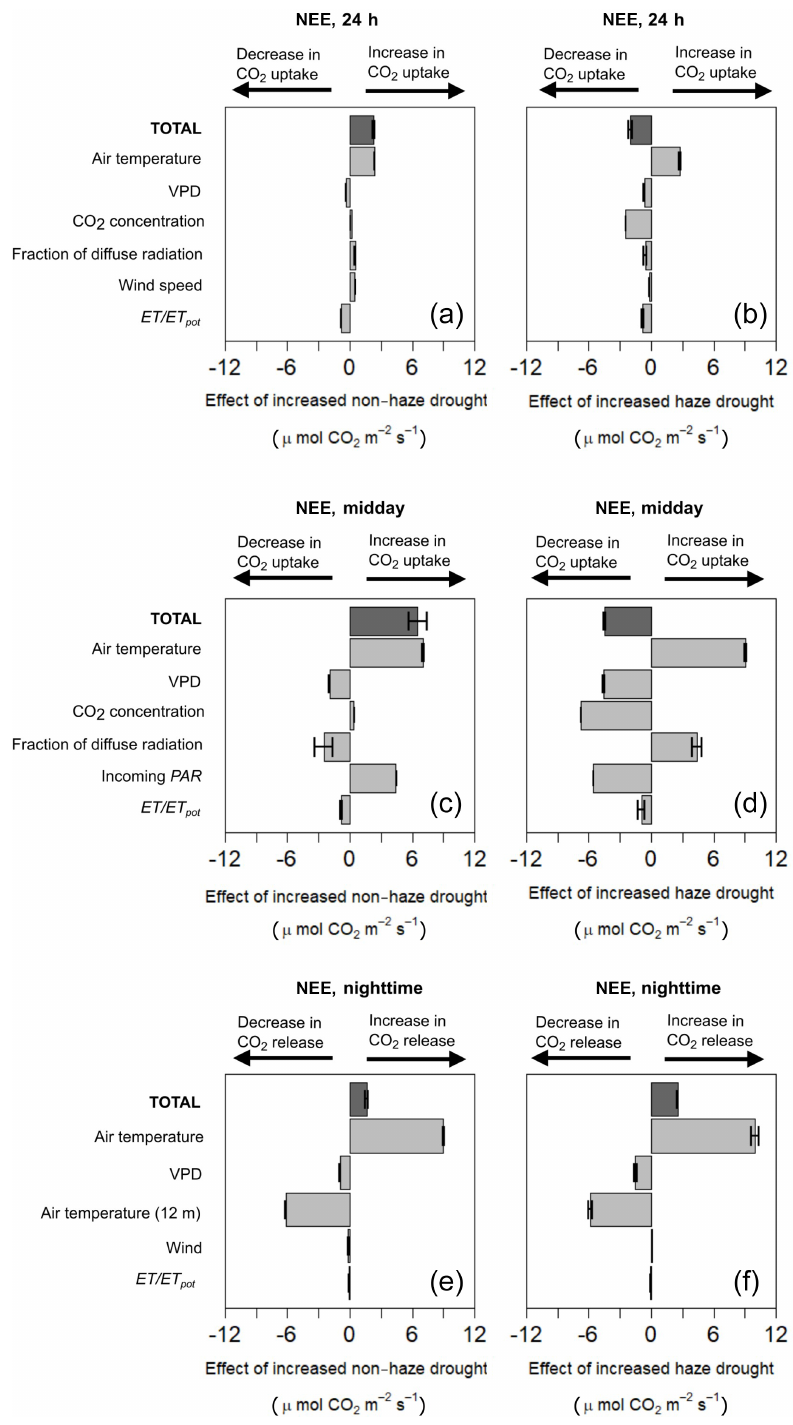
Figure 7. Contribution and effect of meteorological and environmental parameters considering increased non-haze drought (NHD + ) and increased haze drought (HD + ) scenario on the 24h (a, b) , midday (c, d) and night-time (e, f) net ecosystem CO 2 exchange (NEE) using a multiple linear regression model (MLRM). Error bars show the standard